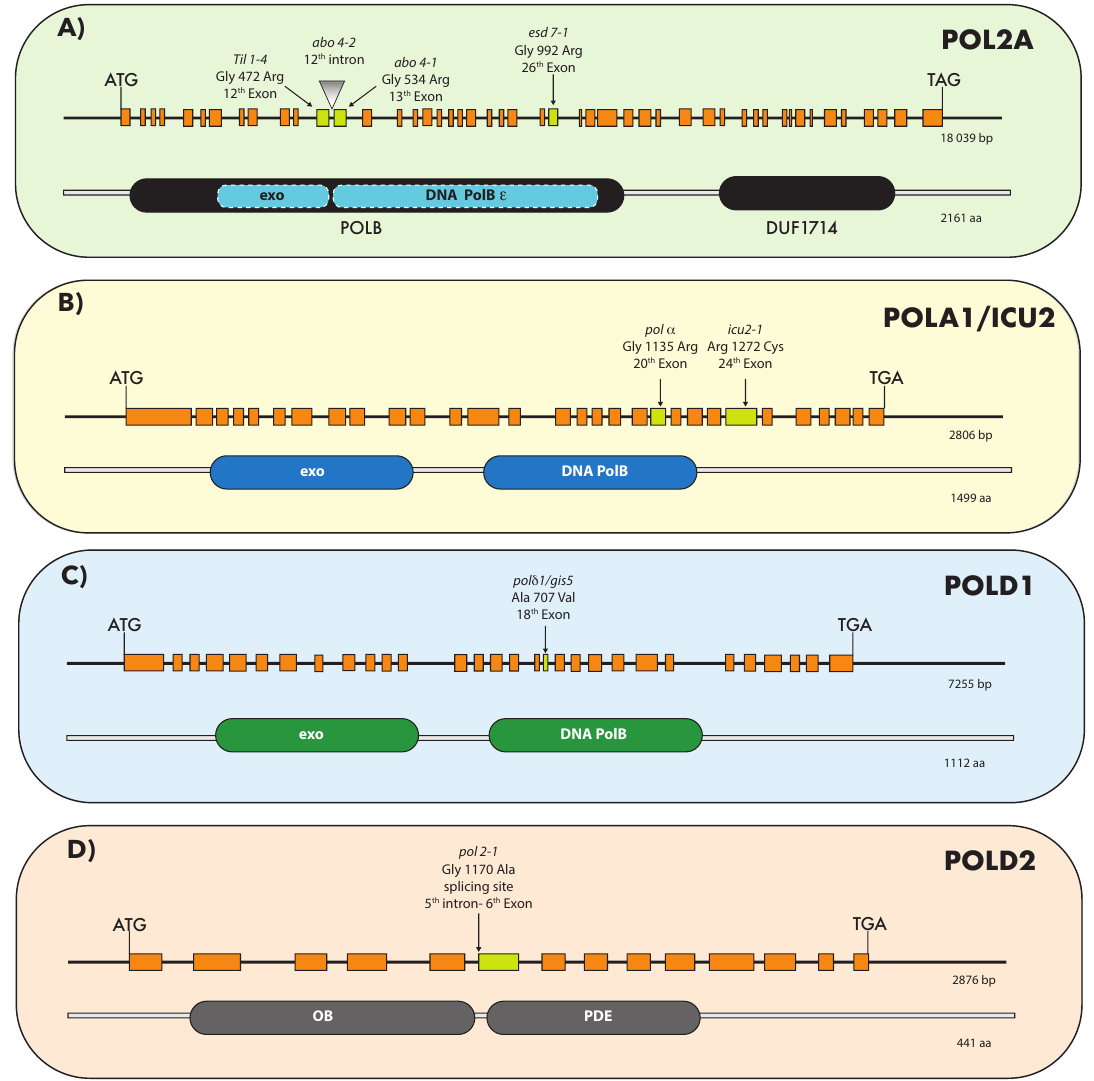
Figure 1. Hyphomorphic alleles of replicative DNA polymerases (Pols) in Arabidopsis thaliana . On all panels, orange boxes represent exons, and the black line represents introns and regulatory